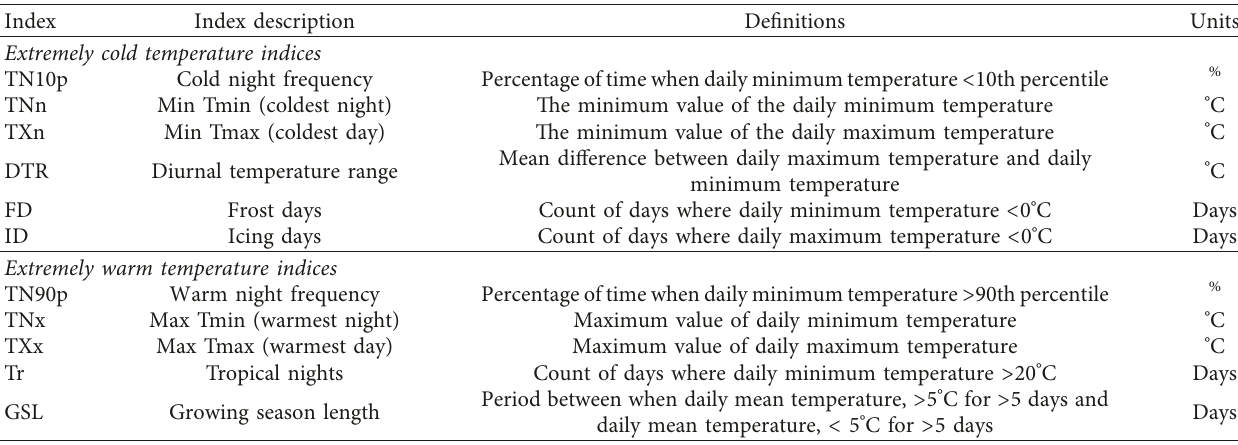
Table 1: Description of the temperature indices used in this paper; all the indices are computed using RClimDEX.